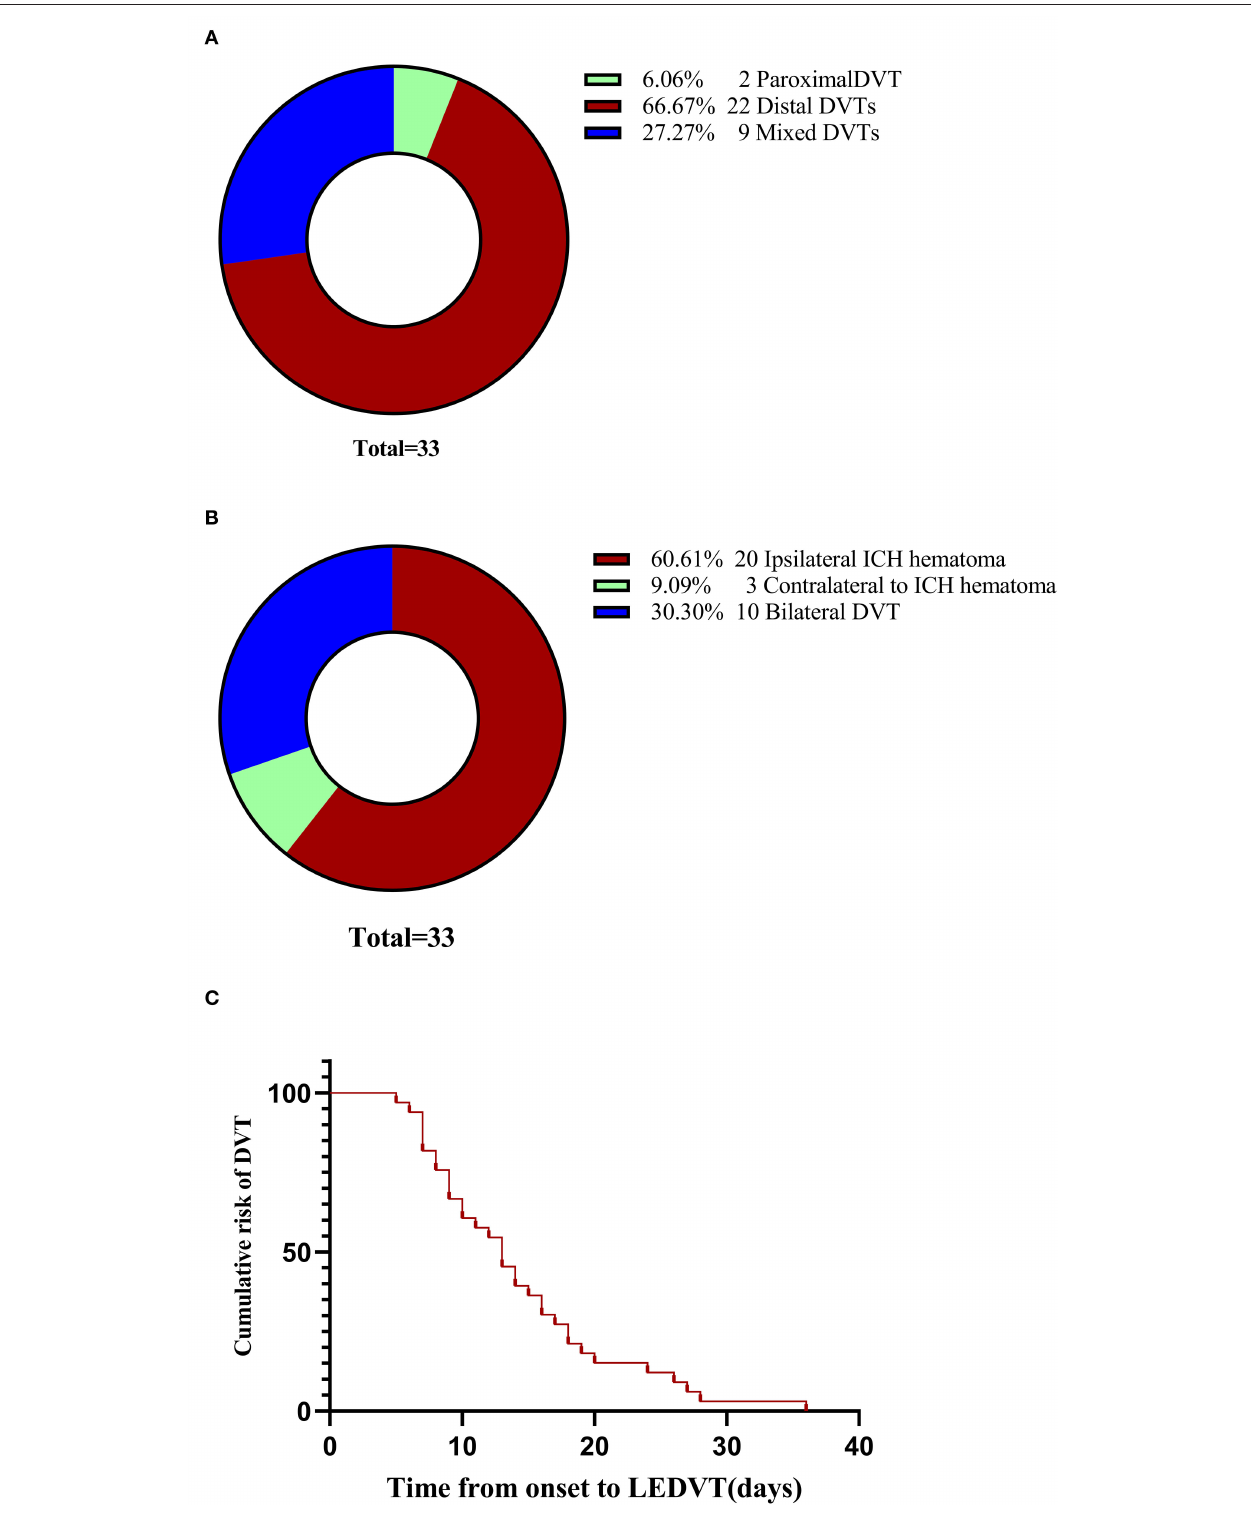
Frontiers in Neurology | www.frontiersin.org